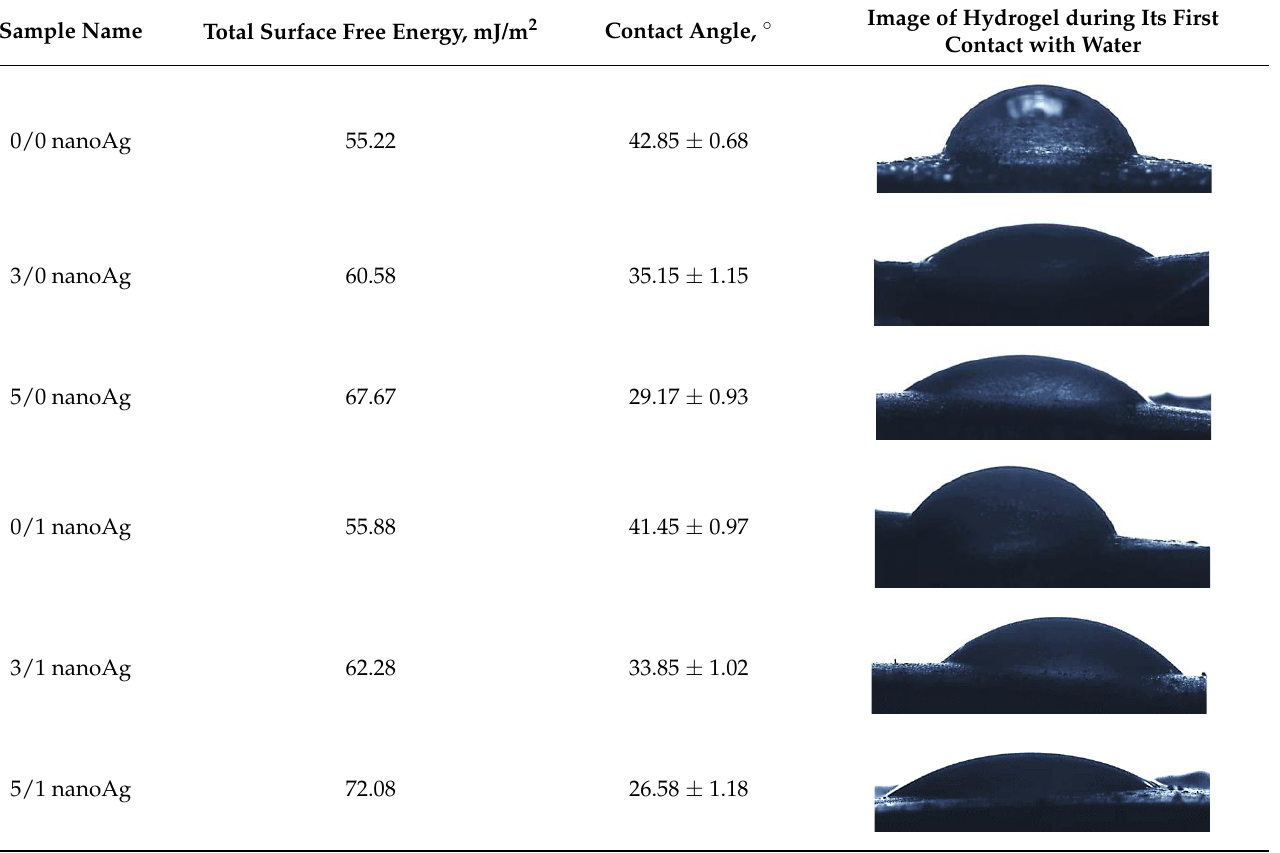
Table 1. Results of hydrogels’ wettability analysis.